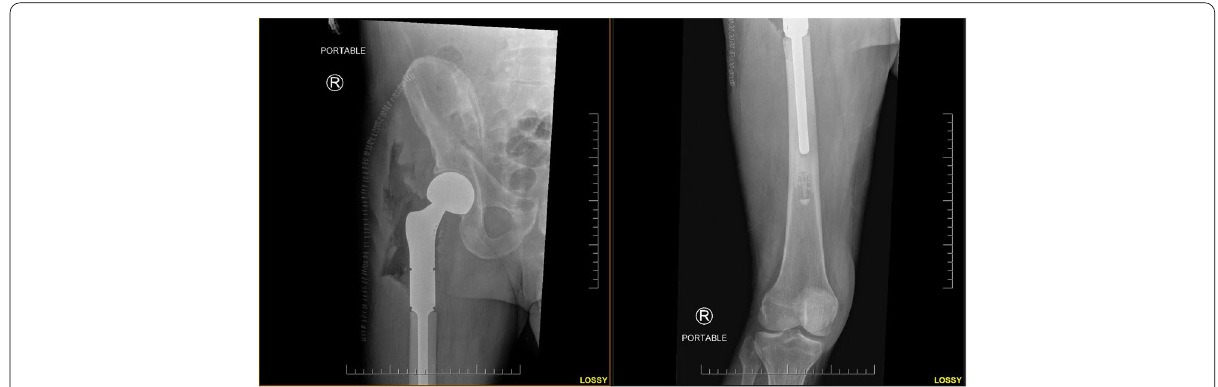
Fig. 1 An AP radiograph showing a proximal femoral replacement using a megaprosthesis